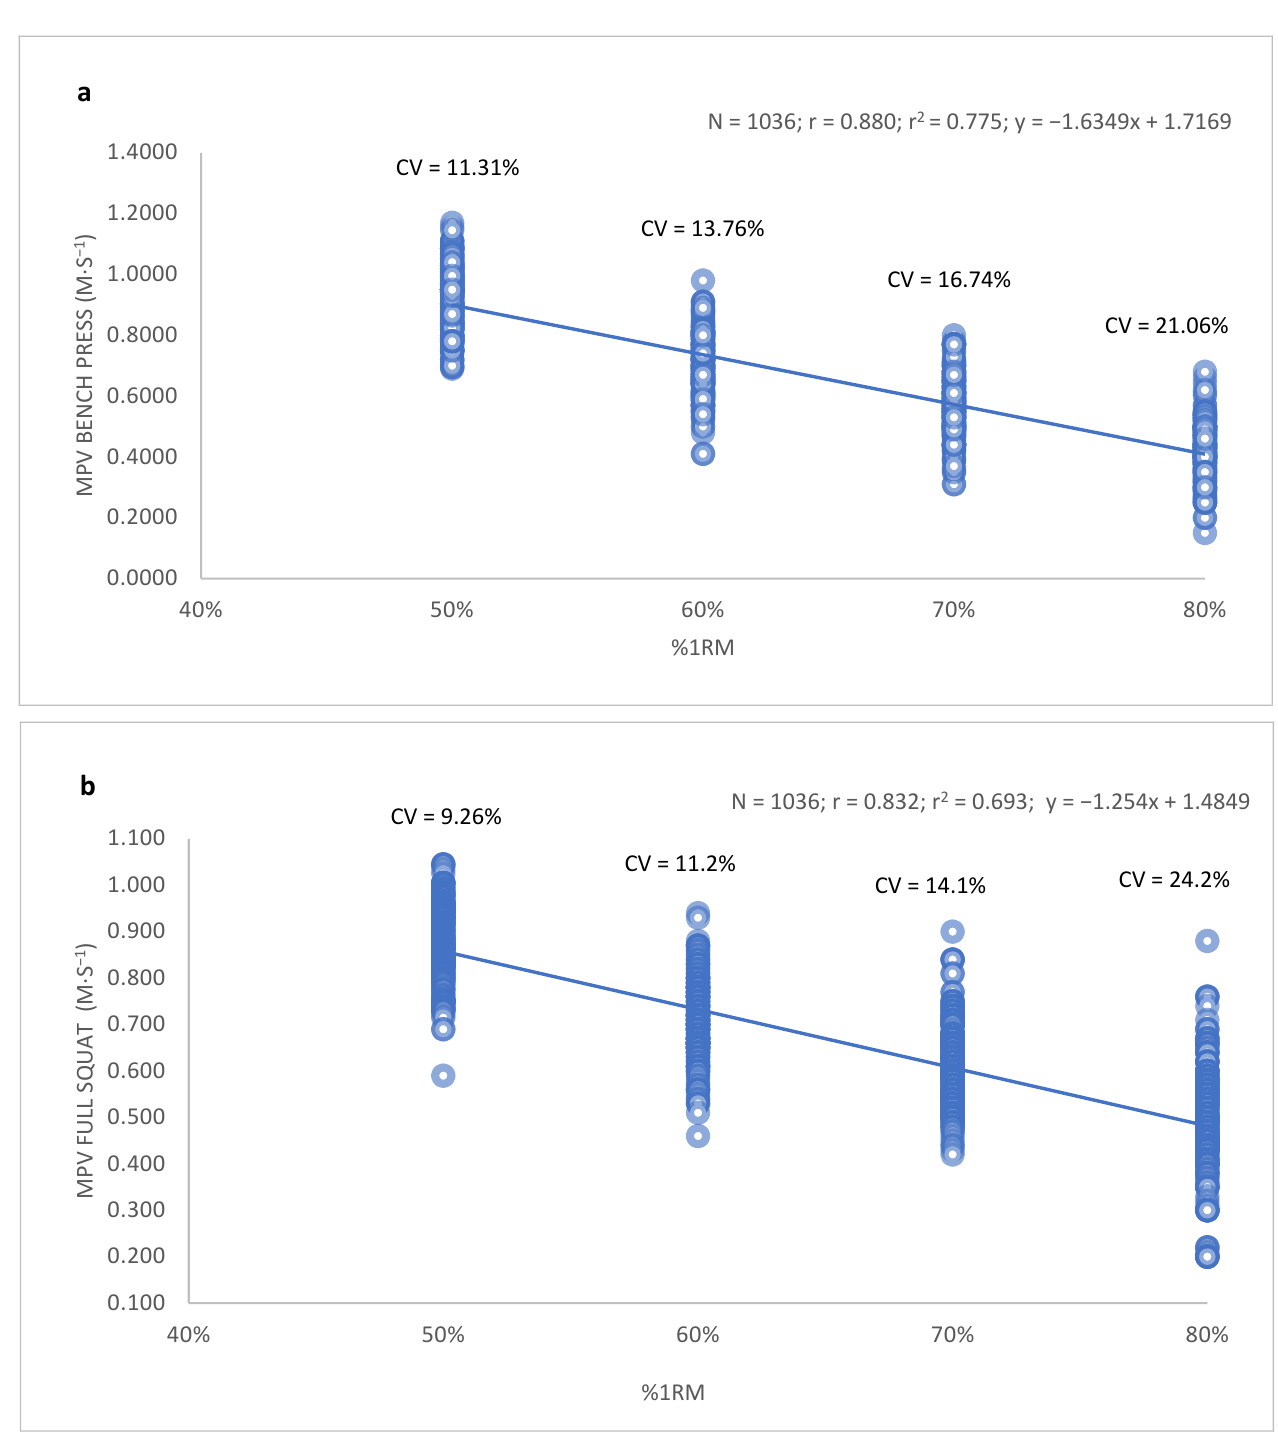
Figure 2. Relationship between MPV and relative load (%1RM) in the group of men for the ( a ) bench press and ( b ) full squat movements. Data were obtained from the values of the mobilization velocity of the isoinertial progressive load carried out in the sample of 259 young men.